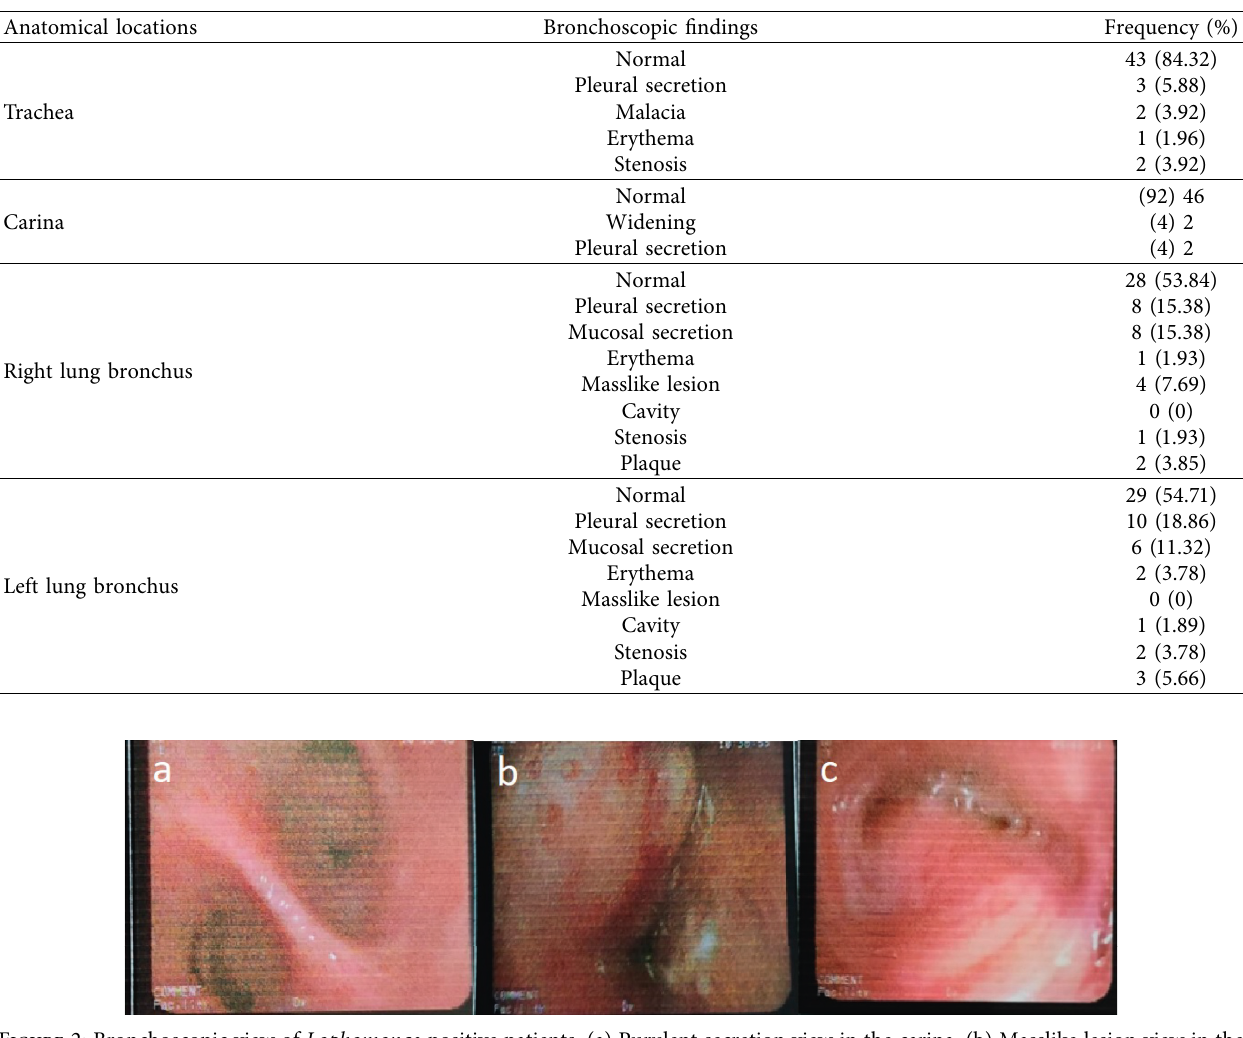
Table 3: Frequency of bronchoscopic findings of patients with Lophomonas infection referred to the INRCL according to the anatomical